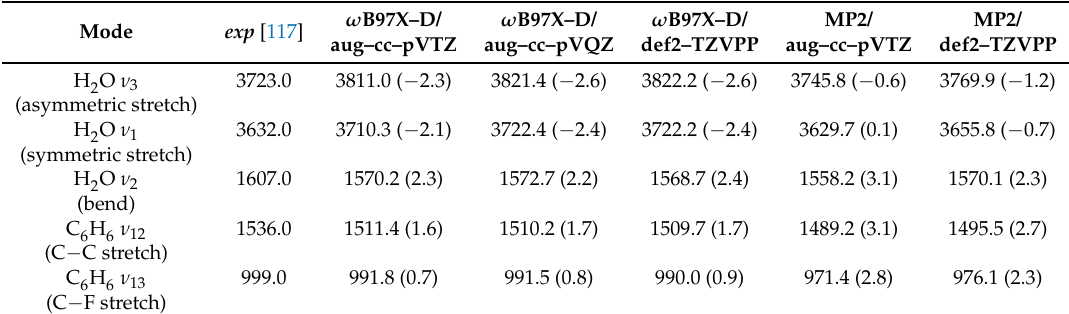
Table 1. Comparison of experimental exp normal mode vibrational frequencies ω exp , with theoretical normal mode vibrational frequencies ω µ for 1 computed at the ω B97X–D/aug–cc–pVTZ, ω B97X–D/aug–cc–pVQZ, ω B97X–D/def2–TZVPP, MP2/aug–cc–pVTZ , and MP2/def2–TZVPP levels of theory.